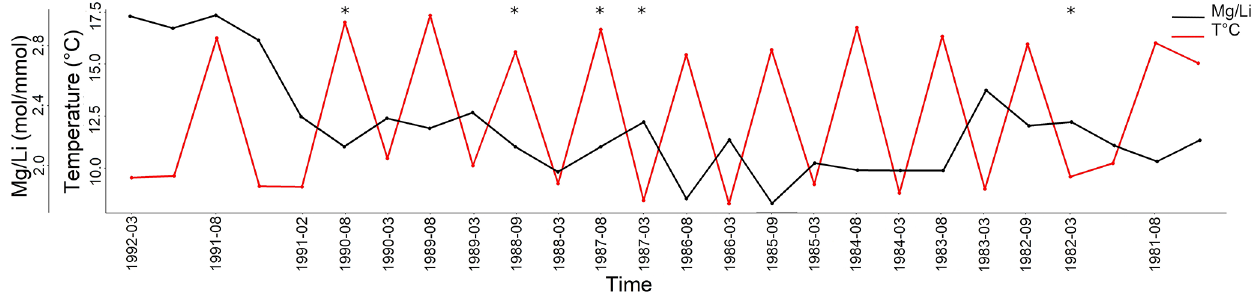
Figure 7. Mg / Li ratio of L. corallioides collected in Morlaix Bay. Note the lack of cyclic variations in Mg / Li results. In the timeline, the coldest and the warmest months have been reported. Mg / Li ratios in the missing bands (asterisks) have been calculated as the means of the values measured in warm and cold periods. Monthly means of seawater temperature have been extracted by ORAS5 reanalysis.